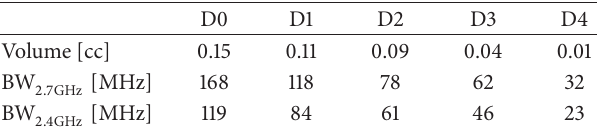
Table 3: Design characteristics.